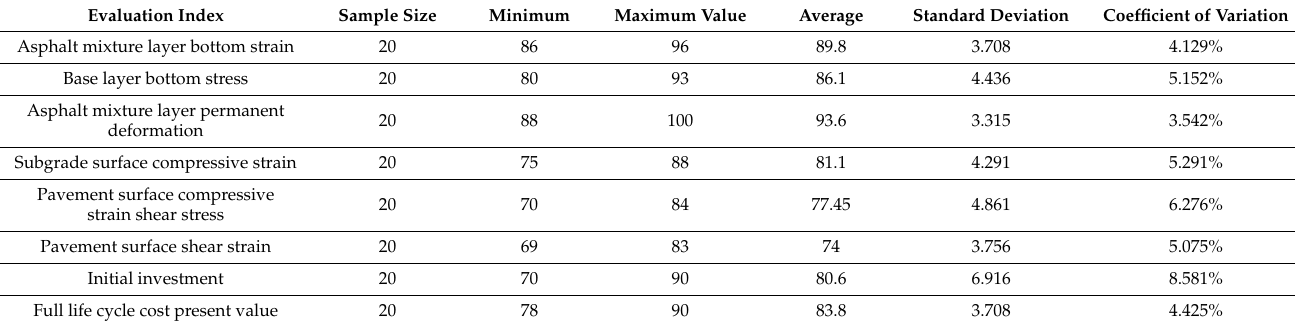
Table 4. Results of the second round of expert consultation.